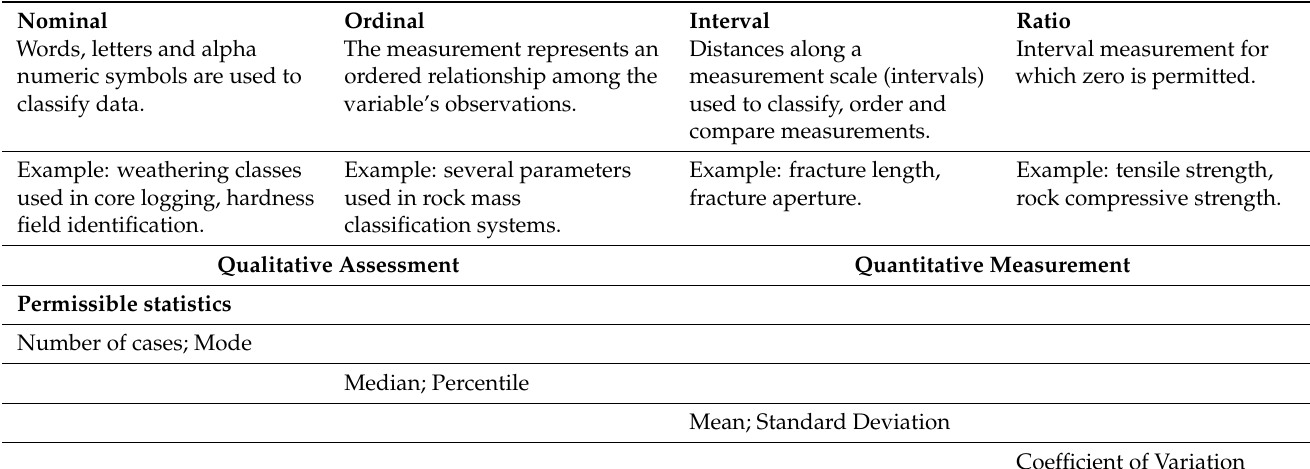
Table 1. Scales of measurements. Modified from